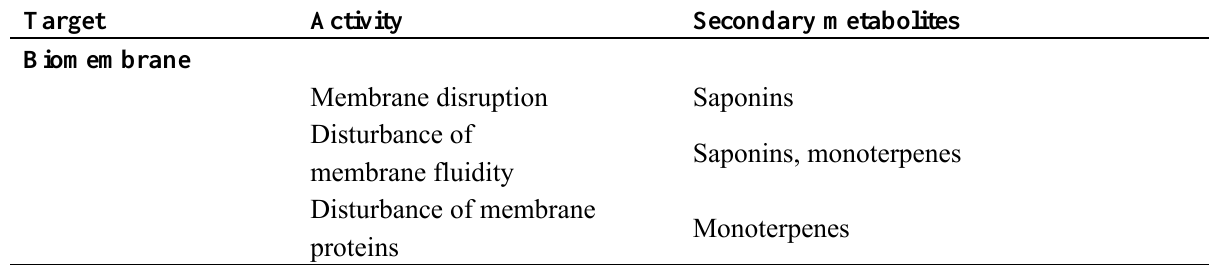
Table 1. Targets in animal cells, bacteria cells and viruses